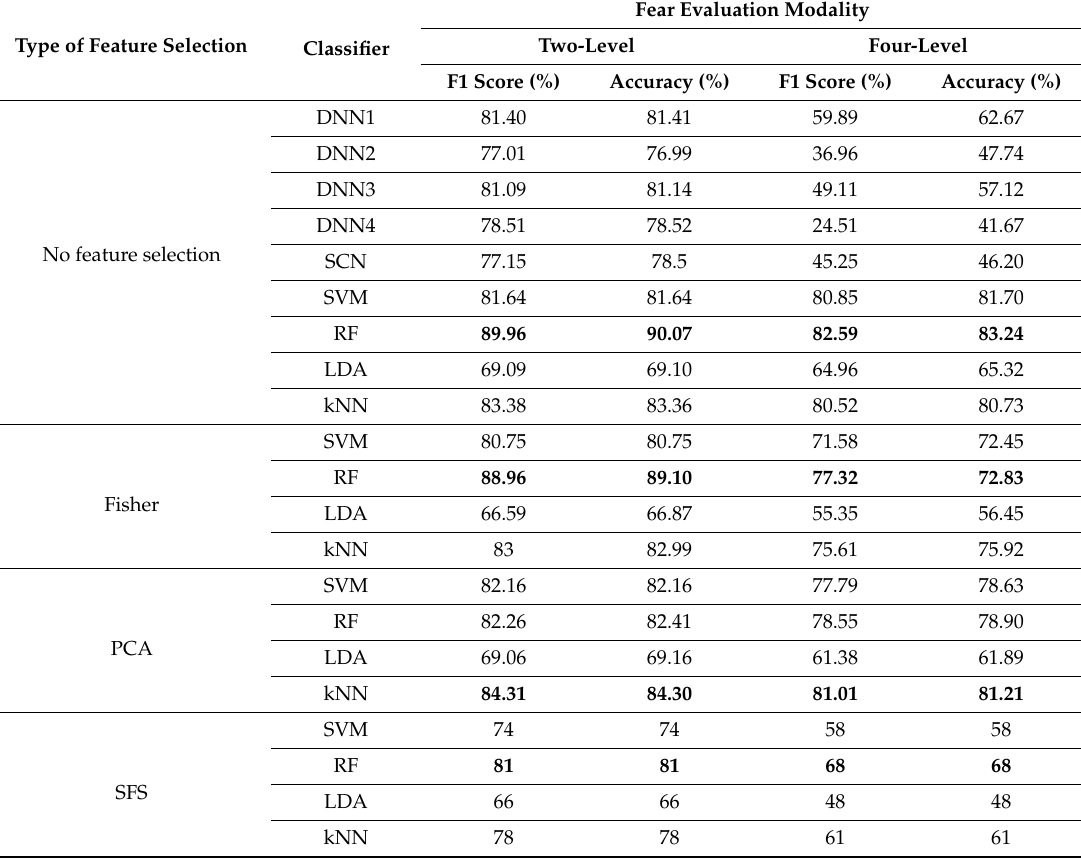
Table 6. Classification accuracy when input is a vector of 32 Higuchi Fractal Dimensions and eight peripheral signals. (The highest accuracies are written with